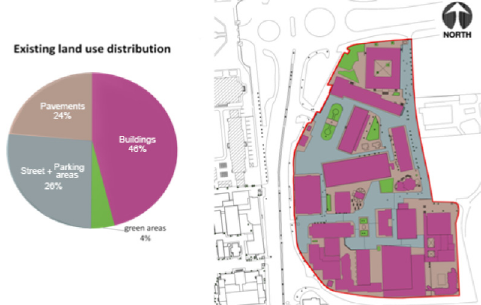
Fig. 3. Campus Land use showing percentage of